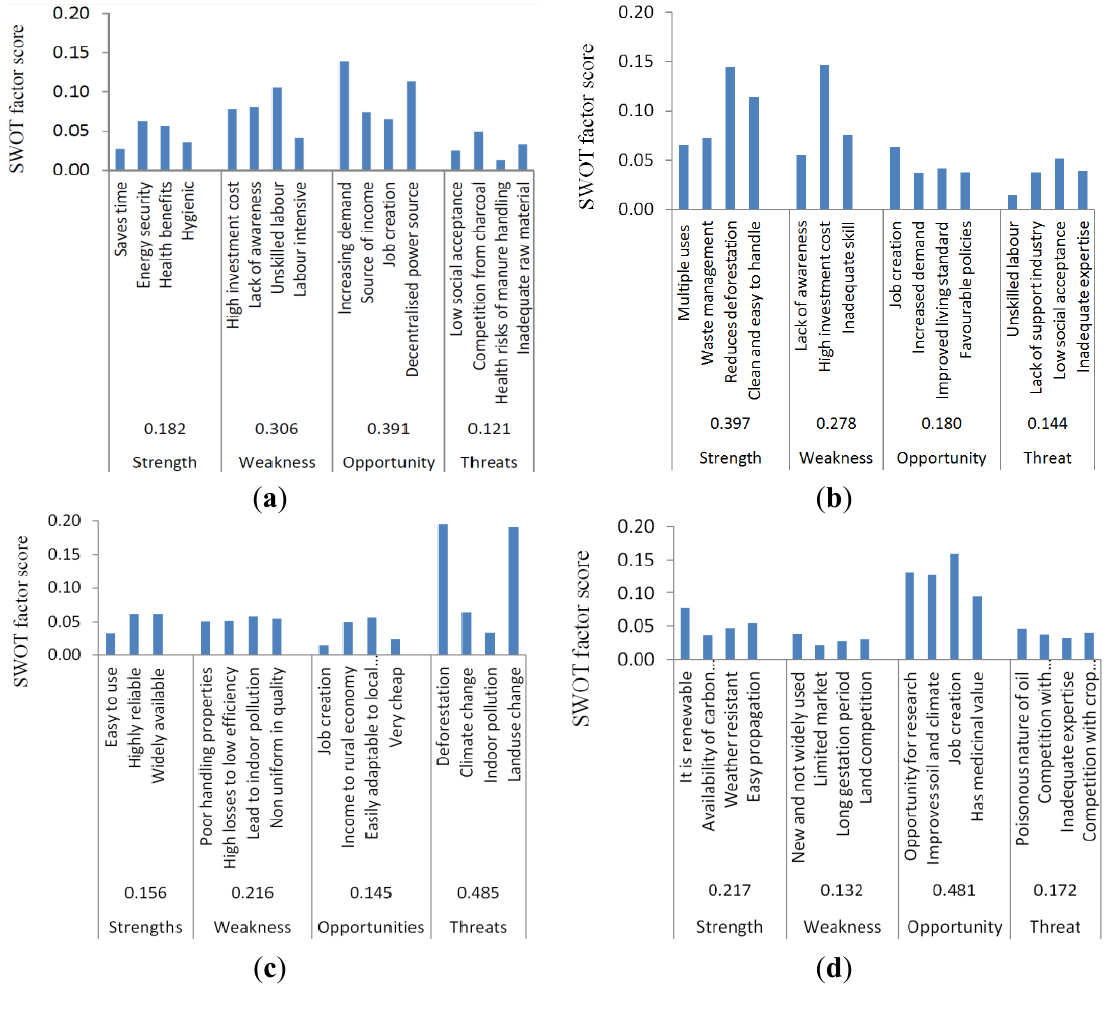
Figure 4. Stakeholder rating of SWOT factors and groups: ( a ) biogas; ( b ) briquettes; ( c ) charcoal; and ( d ) Jatropha. Only data that fulfilled consistency threshold were included in the